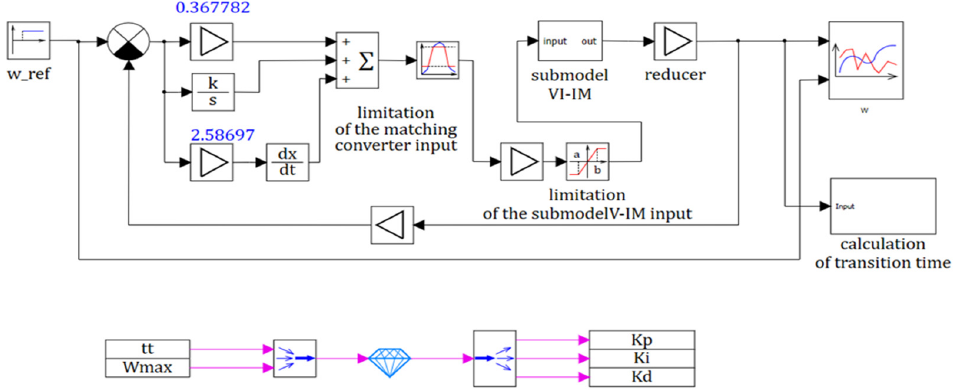
Figure 4. Schematic window with model for parametric synthesis of continuous PID control law.